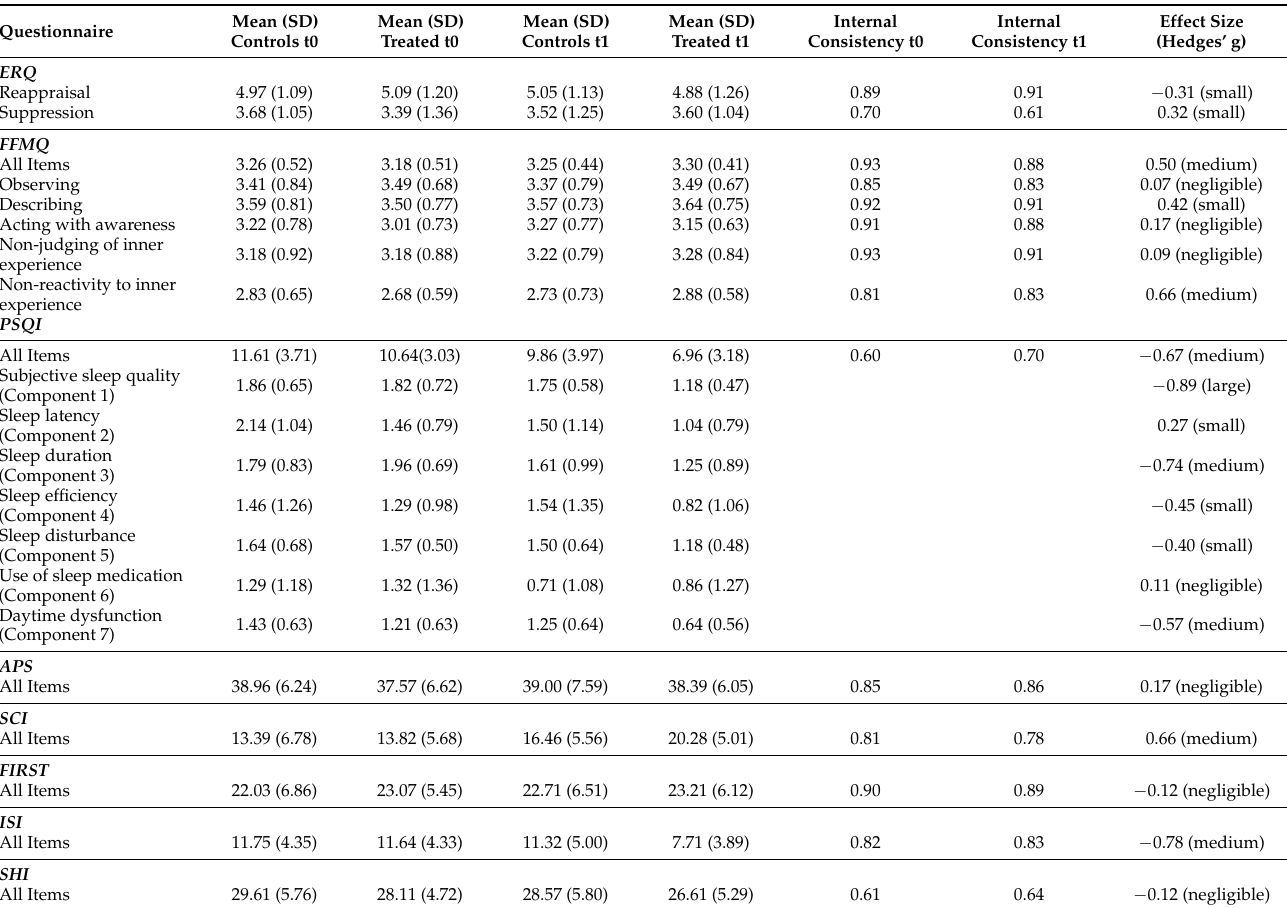
Table 2. Mean, SD, internal consistency, and Hedges’ effect size for each questionnaire and subscale in the two groups (controls and treated) at both time points (t 0 and t 1